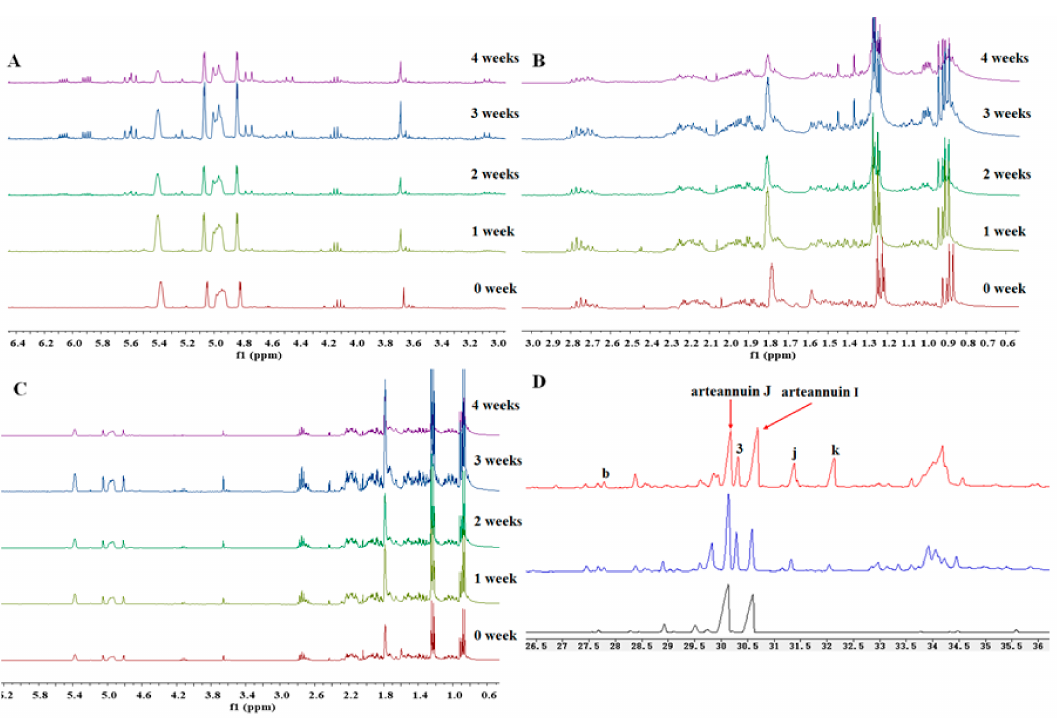
Figure 8. Detection of spontaneous autoxidation products of arteannuin I/J by NMR and GC-MS analyses. ( A , B ): 1 H-NMR spectra of spontaneous autoxidation products under light conditions in CDCl 3 ; ( C ): 1 H-NMR spectra of spontaneous autoxidation products under dark conditions in CDCl 3 ; ( D ): Arteannuin I/J (black), cultured cells in the presence of arteannuin I/J under light conditions (blue), spontaneous autoxidation products of arteannuin I/J (red); b , j , k : Three unknown new peaks; 3 : 2-hydroxy arteannuin